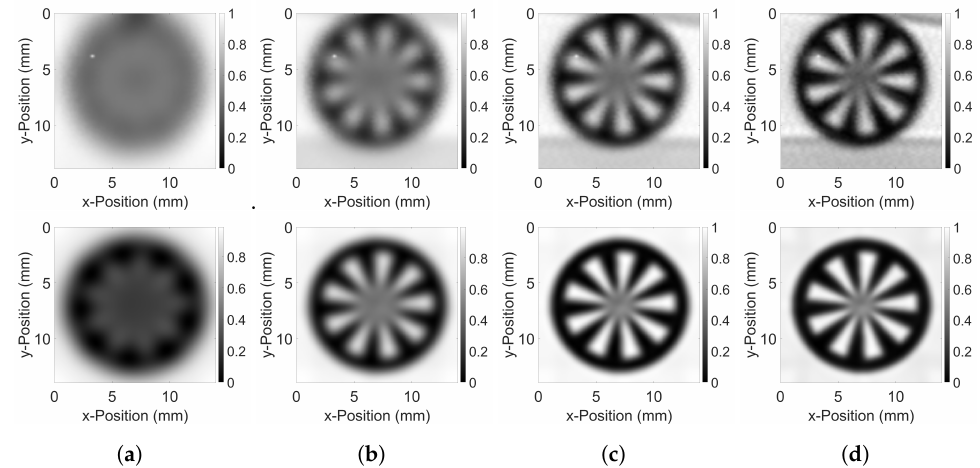
Figure 5. Resolution target images without mask for selected frequencies. Measurement (top) and simulation (bottom); ( a ) 0.5 THz; ( b ) 1.0 THz; ( c ) 1.5 THz; ( d ) 2.0